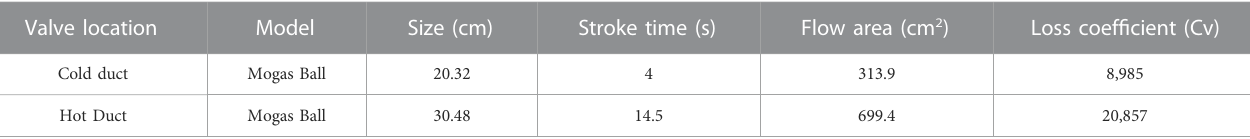
TABLE 3 HTTF cross-ducts break valve